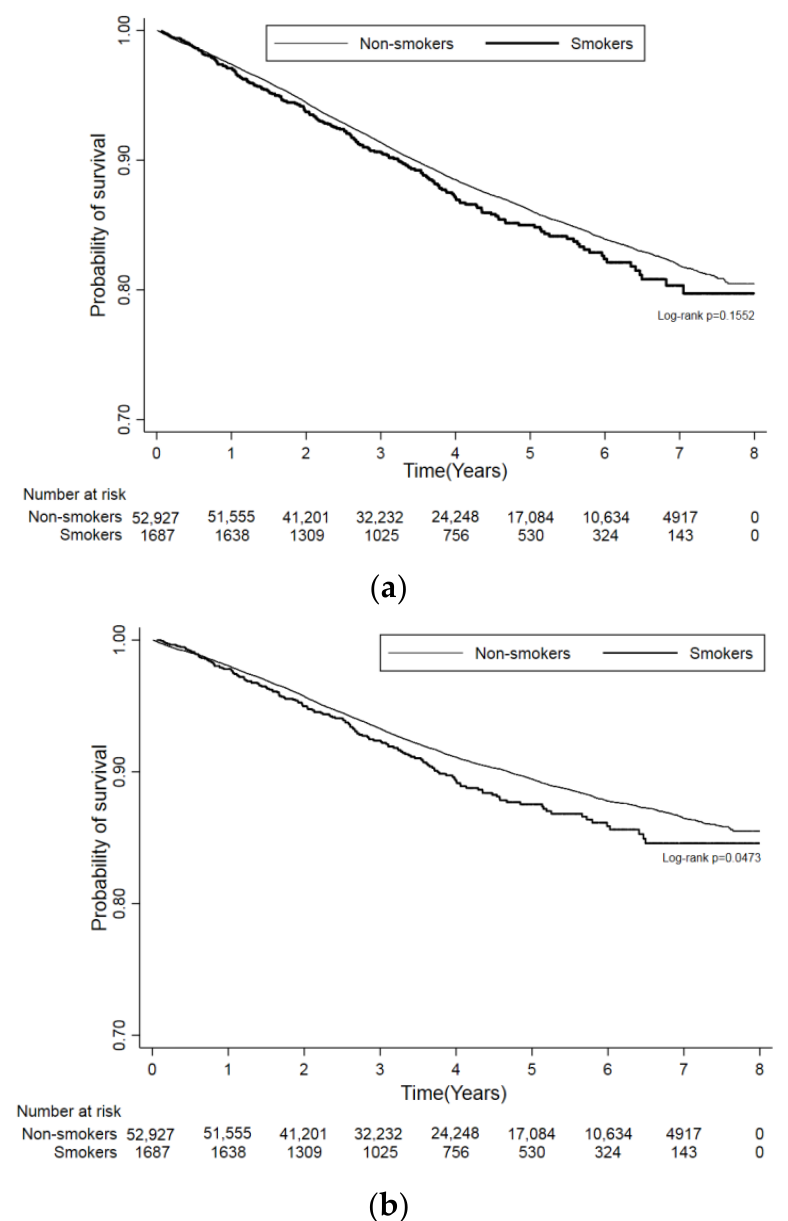
Figure 2. Kaplan – Meier curves for overall mortality ( a ) and cancer-specific mortality ( b ). Figure 2. Kaplan–Meier curves for overall mortality ( a ) and cancer-specific mortality ( b ). The comparison between ever smokers and current smokers regarding overall and cancer-specific mortality risks is shown in Table 3. After adjustments of the selected risk factors, current smokers had a 1.57-fold higher risk (95% CI: 1.03–2.44; p = 0.0407) of overall mortality compared with ever smokers. Additionally, the stratified analysis of mortality risk between women who quit smoking and those who did not smoke is presented as Table 4. Current smokers who drank alcohol (HR: 3.08; 95% CI: 1.38–6.85; p = 0.0058), had